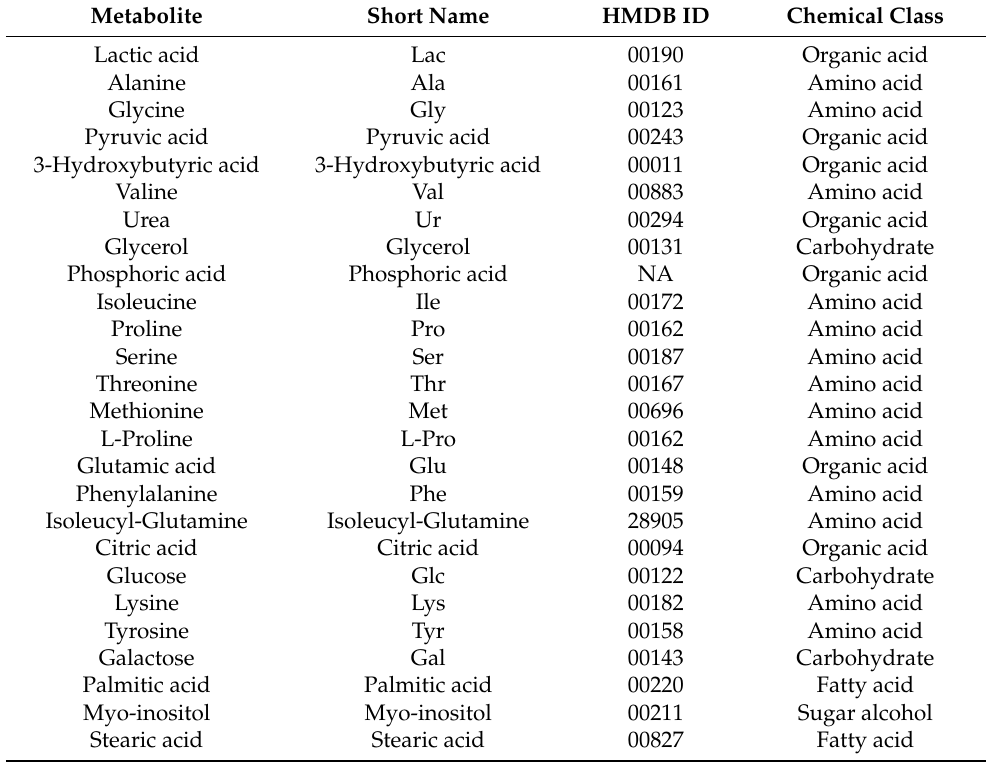
Table 3. List of all metabolites identified in serum samples of dogs infected with B. canis versus healthy dogs obtained by GC-MS metabolomics approach. NA—not